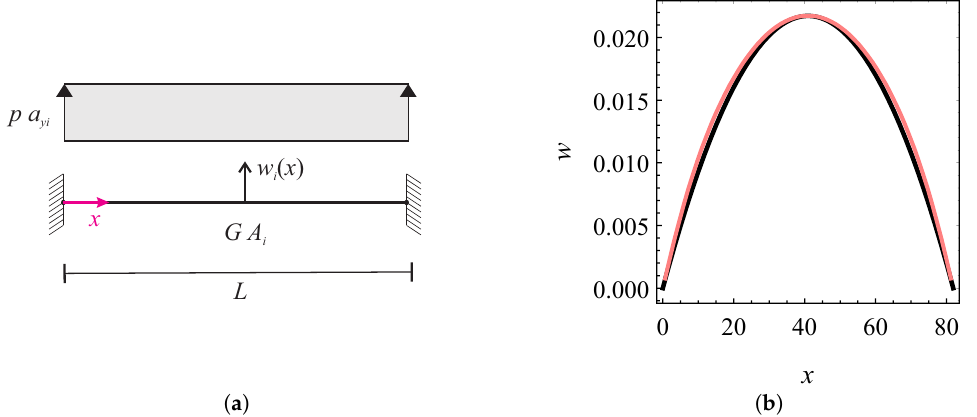
Figure 9. ( a ) scheme of the shear beam equivalent to the i -plate; ( b ) comparison between analytical (pink line) and numerical (black line) deformations in the x − z plane for the plate 5; quantities in meters.